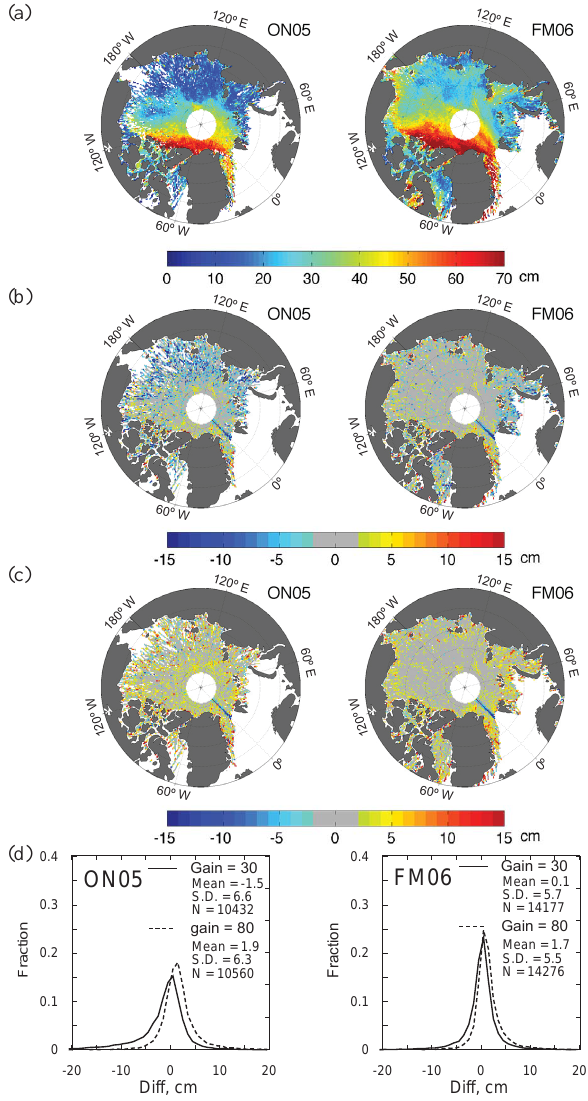
Figure 2. (a) Freeboard retrieved by the LLE method using along- track averaging scales as applied by Yi and Zwally (2009) to de- rive the GSFC product and (b–d) its differences from the GSFC freeboards (freeboards from this study minus GSFC freeboards) for ON05 and FM06 periods gridded into 25km bins (cm). The free- boards estimated in this study are obtained using ICESat data with receiver gain of smaller than 30 (b) and 80 (c) . (d) Distribution of the differences between freeboards. An artefact line of negative dif- ferences along the 0 longitude in (b) and (c) is due to an unexplained positive anomaly in the GSFC freeboard estimates.